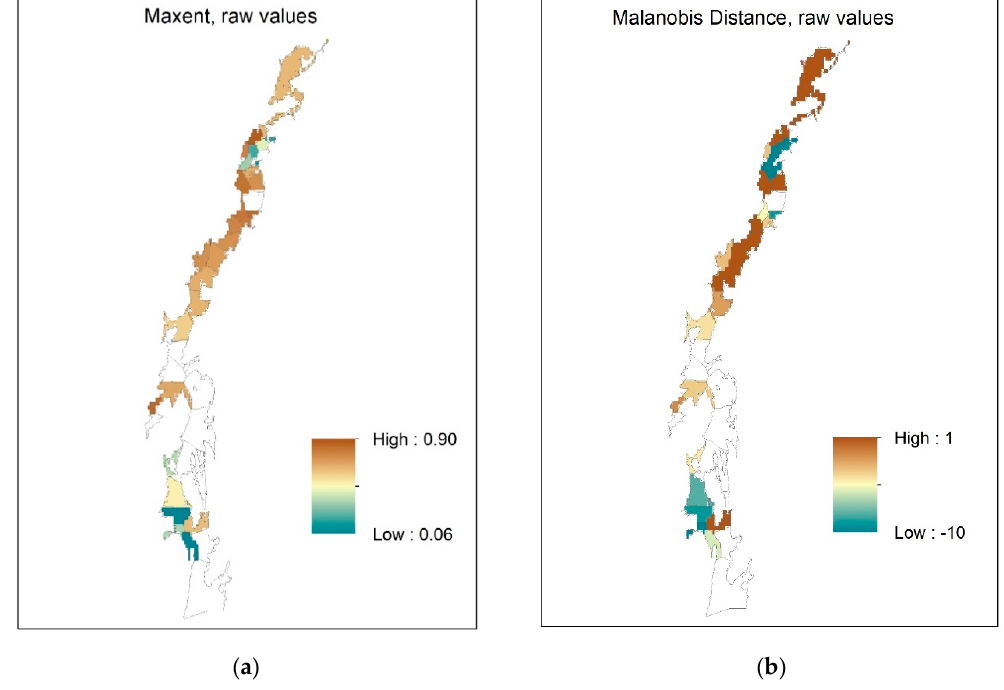
Figure 9 . ( a ) Raw scores for the Maxent model at Damariscotta and ( b ) raw scores for Mahalanobis models at Damariscotta. Scores apply to Voronoi cells. The results show a general agreement on site similarity /suitability between the models.